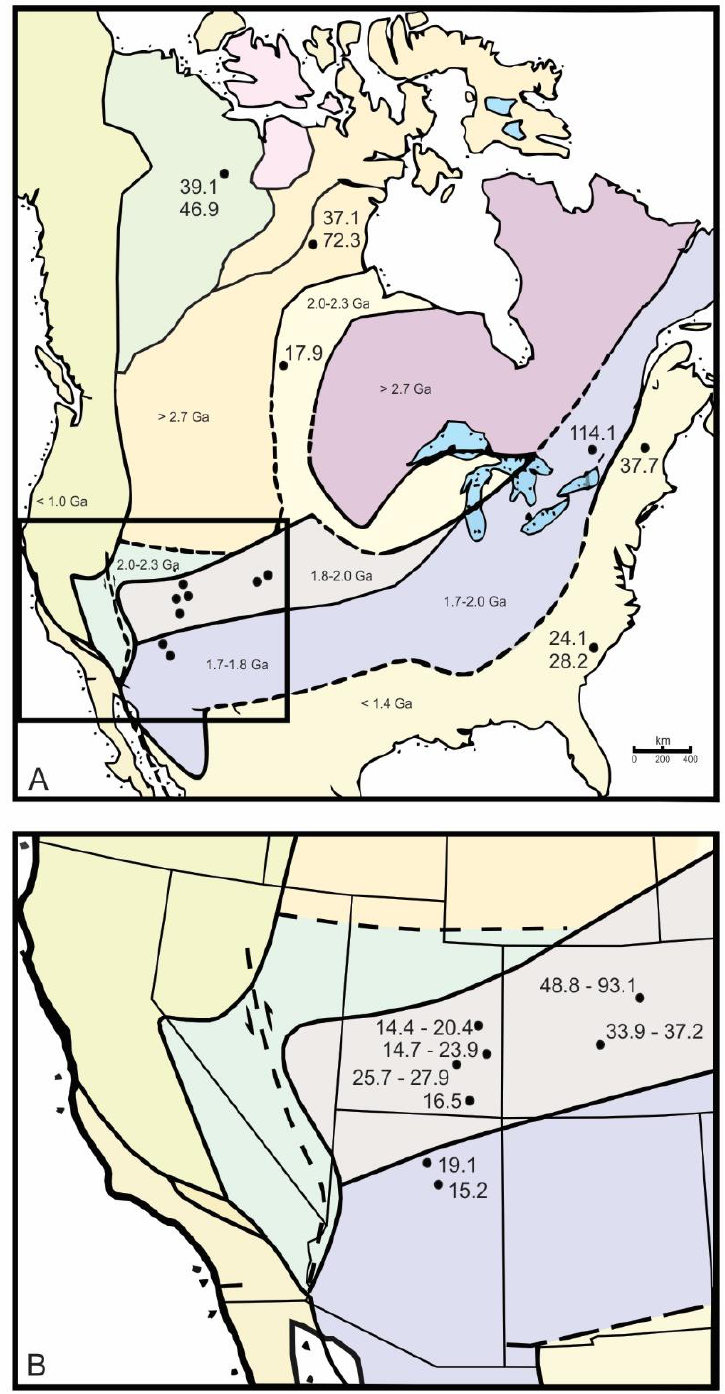
Figure 3. ε Sr values (as defined in text) of uraninite from this study and Corcoran et al. [59]. Colors do not have any geological significance. ( A ) Map of North American cratons with associated Nd model ages modified from Bennett and DePaolo [21]; ( B ) inset of western United States.